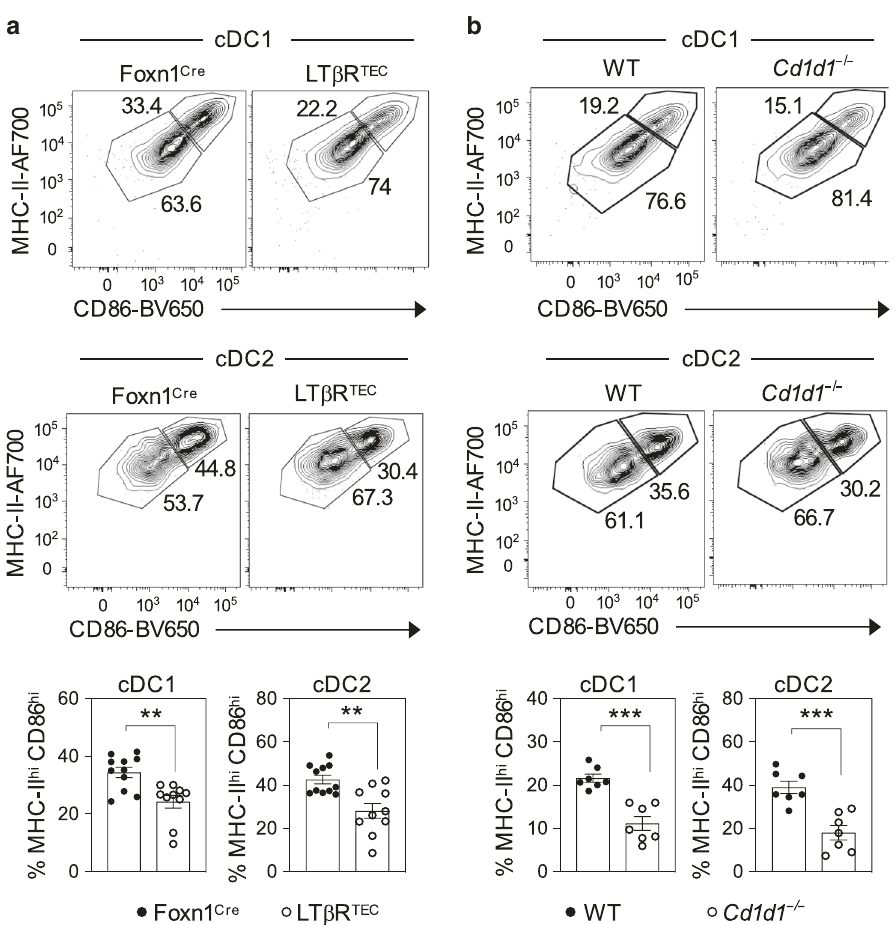
Fig. 7 Impaired dendritic cell activation in LT β R TEC mice. Flow cytometric analysis of CD86 and MHCII expression by Lin − CD11c + Sirp α − cDC1 and Lin − CD11c + Sirp α + cDC2 in the thymuses of a Foxn1 Cre ( n = 10 biologically independent samples, closed symbols) and LT β R TEC ( n = 11 biologically independent samples, open symbols), and b WT ( n = 7 biologically independent samples, closed symbols) Cd1d1 − / − ( n = 7 biologically independent samples, open symbols). In both cases, graphs in lower panels show quantitation of MHCII hi CD86 hi cDC1 and cDC2 (gated as in upper panels). All data are from three independent experiments. Signi fi cant P values using two-tailed unpaired t test are as follows: a cDC1 P = 0.0018, cDC2 P = 0.0014, b cDC1 P = 0.0001, cDC2 P = 0.0004. All data are represented as mean ± SEM. *** P < 0.001 and ** P < 0.01. Source data are provided as a Source Data fi